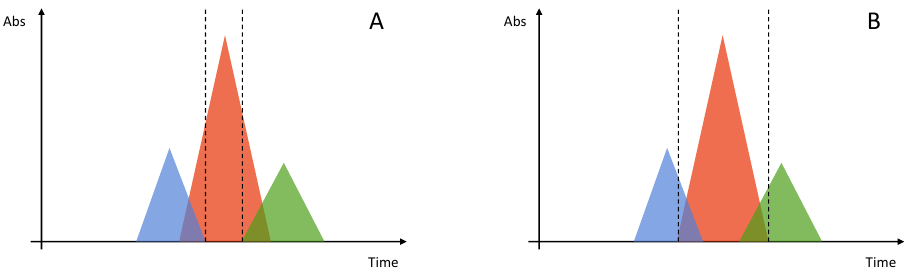
Figure 6. The red peak represents the target product, eluting between a group of impurities more weakly adsorbed (blue peak) and a group of impurities more strongly adsorbed (green peak). When deciding which portion of the main peak to collect, two cases are possible: ( A ) narrow collection window leads to higher purity but lower recovery; ( B ) broad collection window leads to high recovery but low purity, since also a portion of impurities peaks is collected. This is the so-called “purity-yield